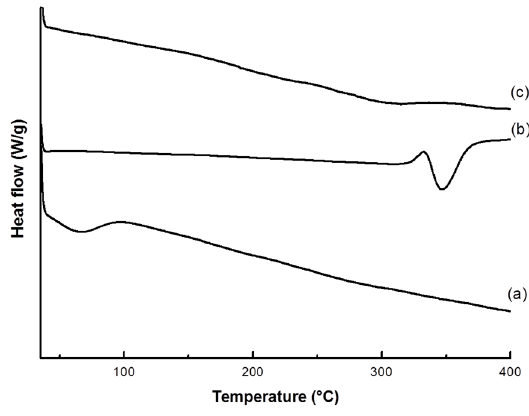
Figure 6. DSC curves of SBA-15 ( a ), VC-IP ( b ), and VC-IP@SBA-15 ( c ).